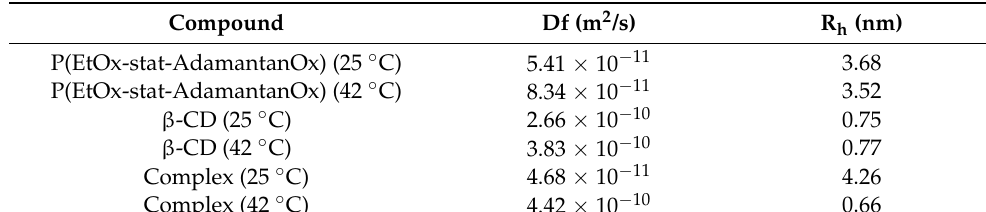
Table 1. Diffusion constant and size of P(EtOx-stat-AdamantanOx), β -CD, and their complexes at a 5:1 guest-to-host ratio above and below the T cp .